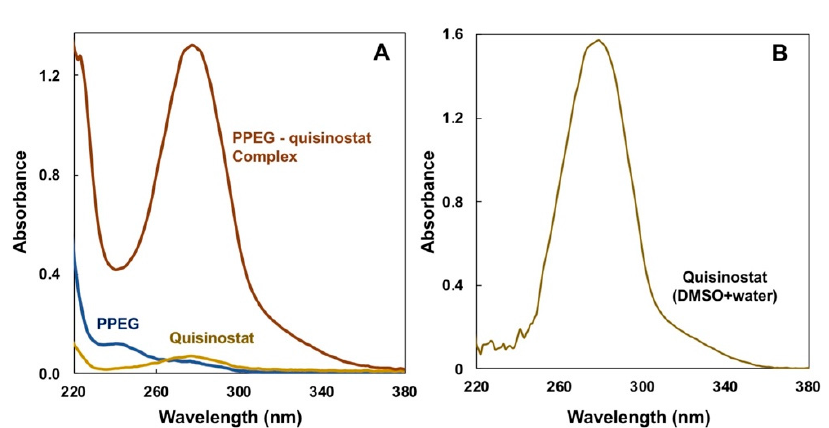
Figure A1. UV profiles of ( A ) PPEG–quisinostat complex after dialysis-driven self-assembly com- pared with the components (PCPP-PEG and quisinostat) dialyzed individually (results for complex with 15:1 quisinostat-to-polymer ratio are shown) and ( B ) quisinostat in DMSO-water mixture.